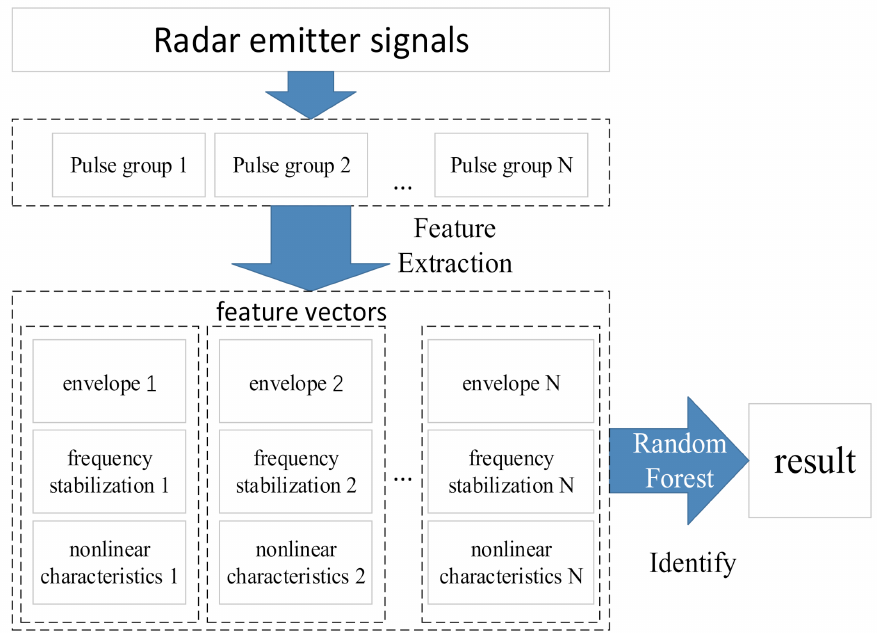
Figure 20. Experimental process.